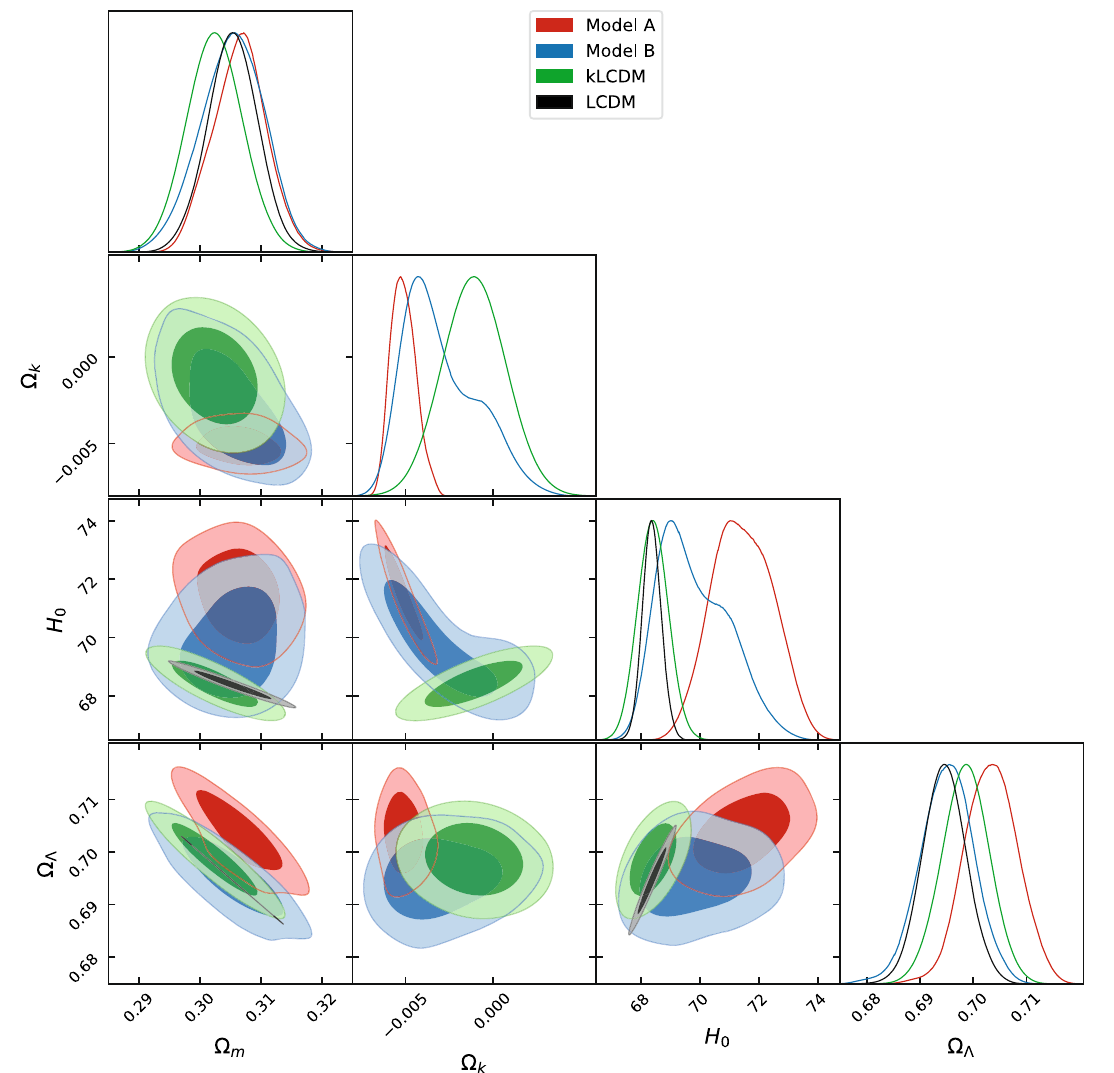
Fig. 1 2D joint and 1D marginalized posterior probability distributions for (cid:2) m ,(cid:2) k , H 0 , and (cid:2) (cid:13) , obtained within our two models A , B and the standard cosmology models, spatially-flat LCDM, spatially-non-flat kLCDM. Contour plots are shown at 1 σ ( 68% ) and 2 σ ( 95% )